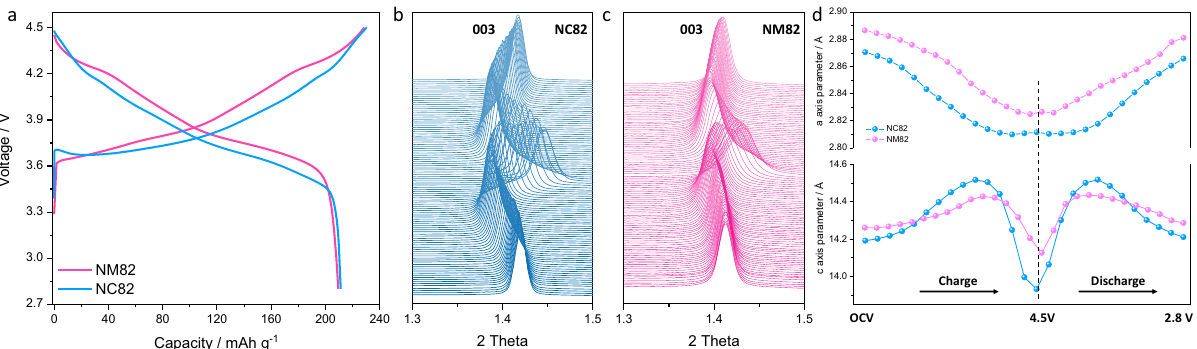
Fig. 1 Structure evolution and lattice parameter changes of NC82 and NM82. a Charge/discharge pro fi les of NM82 and NC82 at a current rate of C/10 within a voltage range of 2.8 – 4.5 V. NM82 and NC82 deliver similar capacities of 209 and 211 mAh g − 1 , respectively. b , c In situ synchrotron HEXRD results of NC82 and NM82 during the initial cycle in the voltage range of 2.8 – 4.5 V using a current rate of C/10 (1C = 200 mA g − 1 ). d The quantitative re fi nements of lattice parameters of NC82